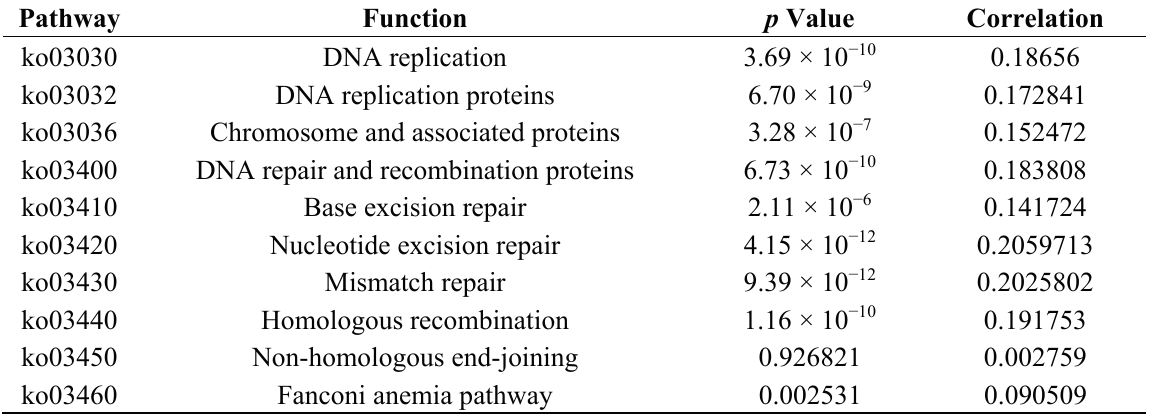
Table 5. Relationship between each type of replication and repair genes and composition